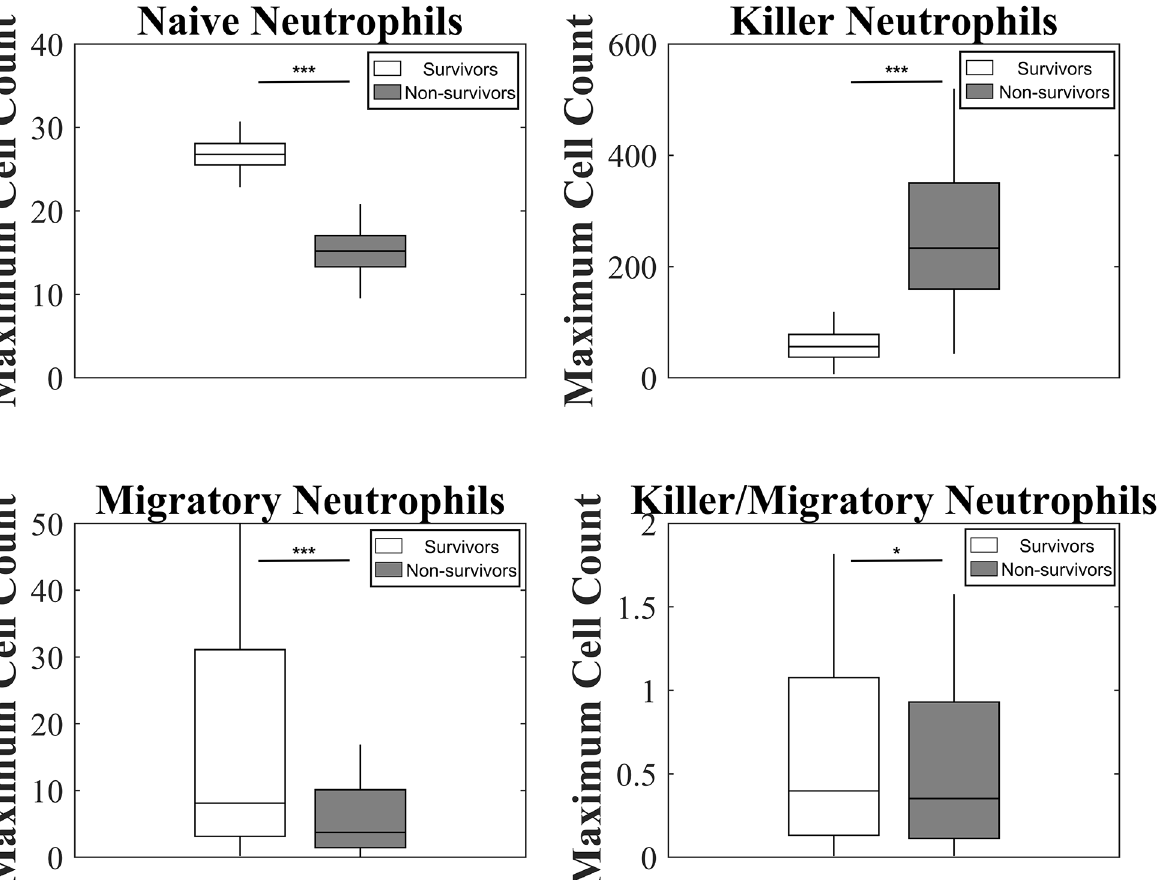
Fig 5. Model predictions for maximal levels of each neutrophil phenotype compared across ensembles. Maximal values for each neutrophil phenotype from each trajectory in both ensembles were recorded. Values for the mean, 25 th -75 th percentile, and 2.5 th to 97.5 th percentiles are shown. Distributions were compared using a two sample T-test. * p < 0.05, ** p < 0.01, *** p <